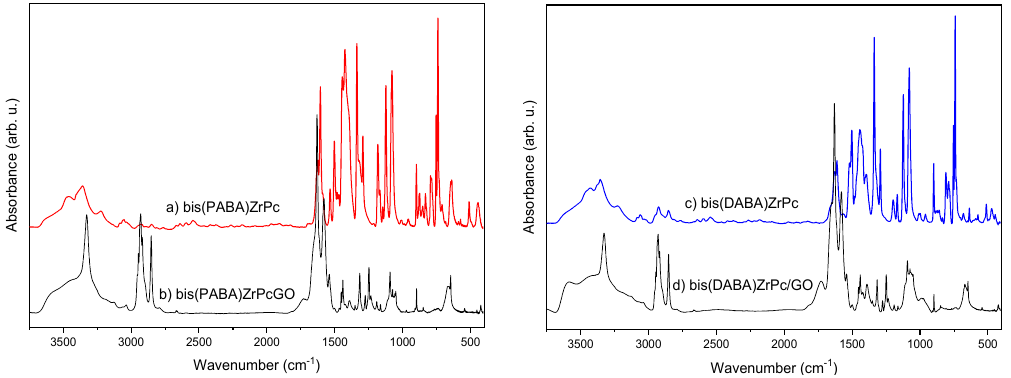
Figure 2. Fourier-transform infrared (FTIR) spectra of (a) bis (PABA) ZrPc, (b) bis (PABA) ZrPc/GO, (c) bis (DABA) ZrPc and (d) bis (DABA) ZrPc/GO.